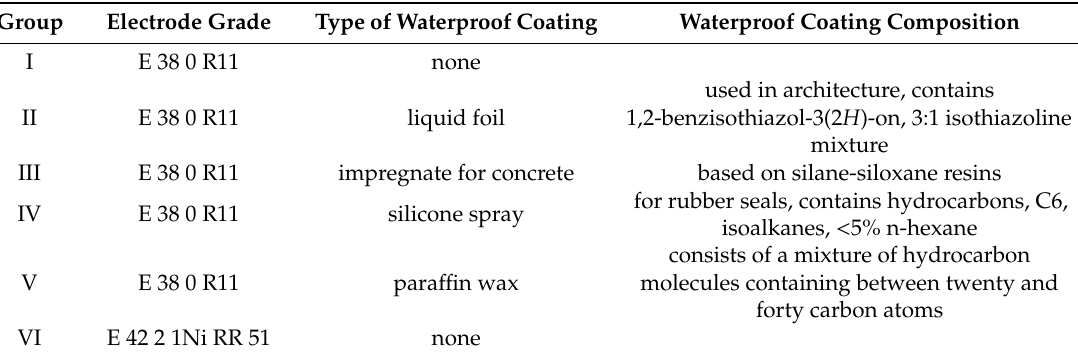
Table 3. Description of electrodes modification.